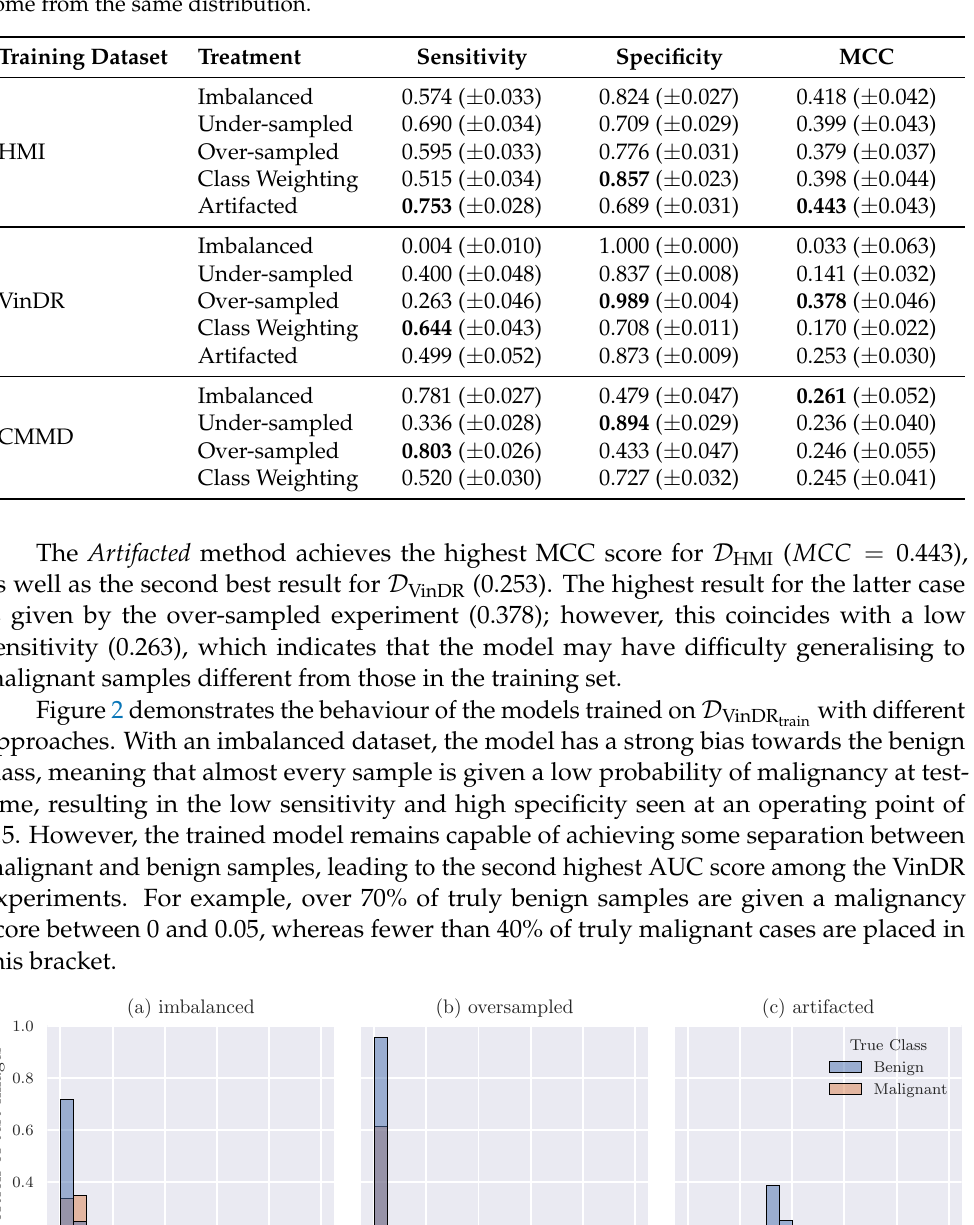
and applied to train